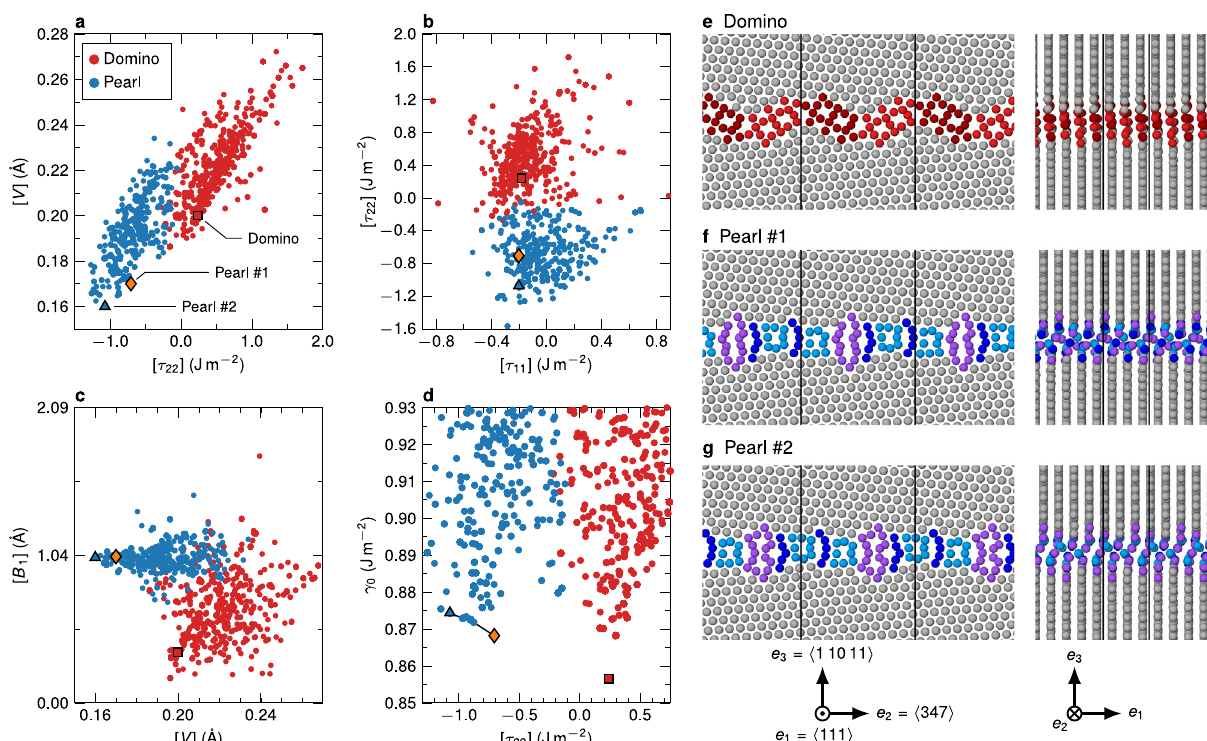
Fig. 4 Grain boundary phases predicted by the EAM potential discovered with phase-space sampling by an evolutionary algorithm. a – c Pair plots of different GB excess properties that make the separation into two main clusters of data points visible. The color coding is according to a clustering algorithm that takes several excess properties into account. Many of the structures that were discovered are simply defective, i.e., they contain disconnections or other defects. Three defect-free base structures are highlighted by the triangle, diamond, and square symbols, in which two are microstates of the pearl phase (the triangle and diamond) and one refers to the domino phase (the square). The best predictor to separate the clusters is ½ τ 22 (cid:2) , but the excess shear also provides a good indicator. d When plotting the GB energy over this predictor, a clear separation between low-energy domino-like and pearl-like structures can be seen. The low-energy pearl variants consist of either pearl #1 or #2, or a mixture of the two (indicated by the line connecting the data points and explored in more detail in Supplementary Fig. 4). e – g Snapshots of the low-energy structures from two directions. The unit cells are marked by black lines.